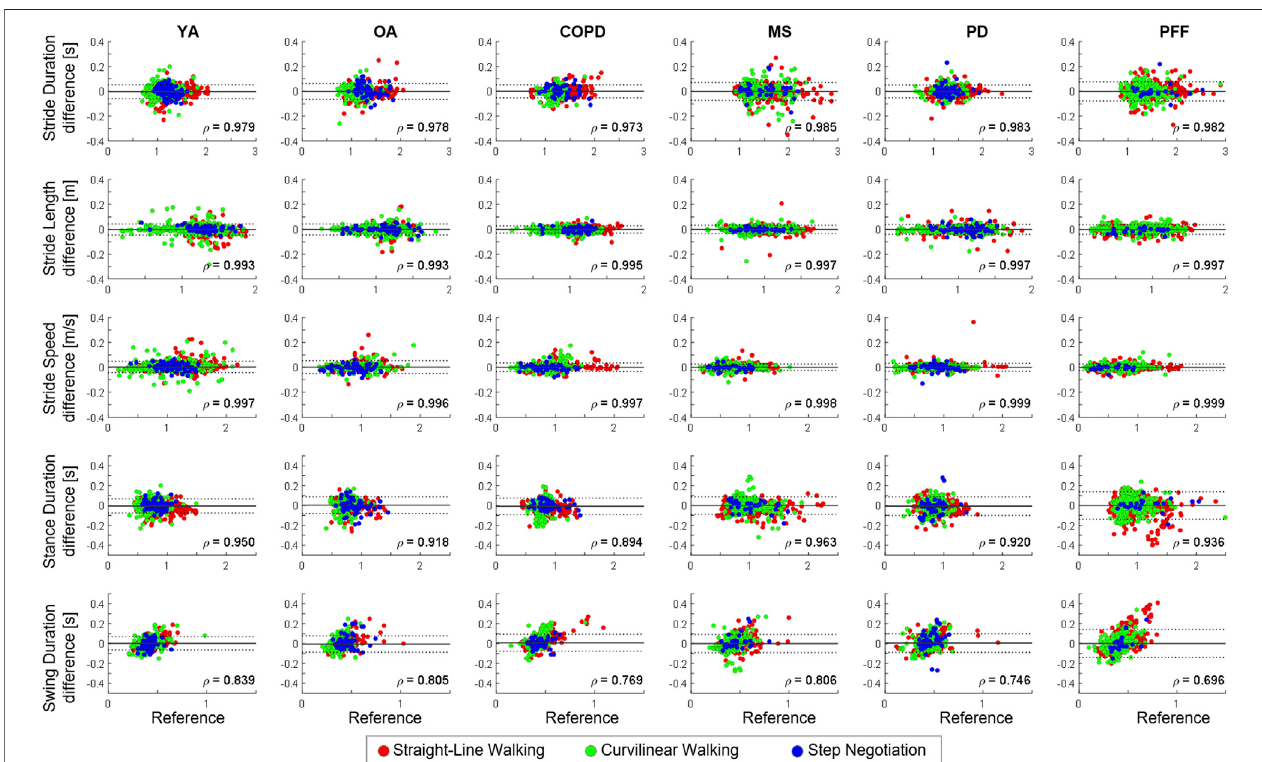
FIGURE4| Bland – Altman(BA)plotsofthedifferentstride-levelparameters[stridelength(m),strideduration(s),stridespeed(m/s),andstance/swingduration(s)]in the young healthy adults (YA), older adults (OA), chronic obstructive pulmonary disease (COPD), multiple sclerosis (MS), Parkinson disease (PD), and proximal femur fracture (PFF) cohorts. Strides detected during straight-line walking, curvilinear walking, and step negotiation are reported in green, red, and blue, respectively. In each BA plot, bias (mean value, gray line) and limits of agreements (bias ±1.96 standard deviations; black with dotted lines) are represented. Spearman correlation coef fi cients ( ρ ) are also shown, all ρ values were statistically signi fi cant ( p <